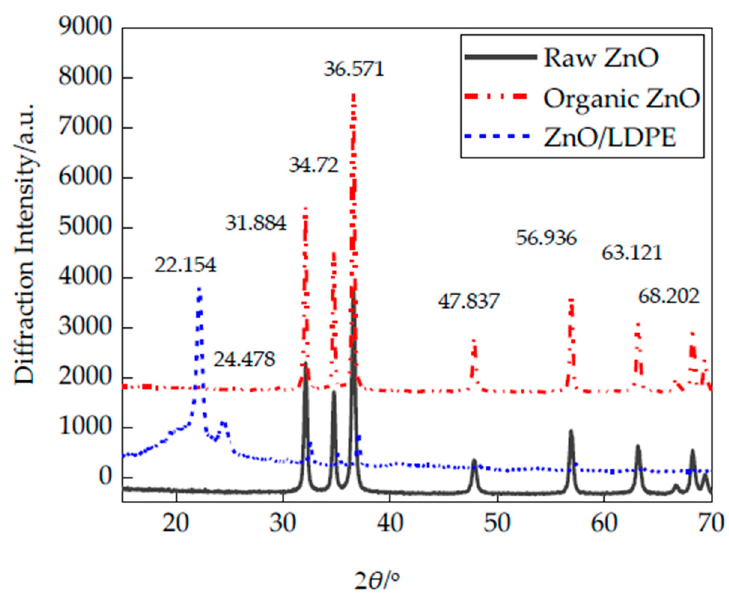
Figure 5. XRD patterns of ZnO particles and ZnO/LDPE specimens.